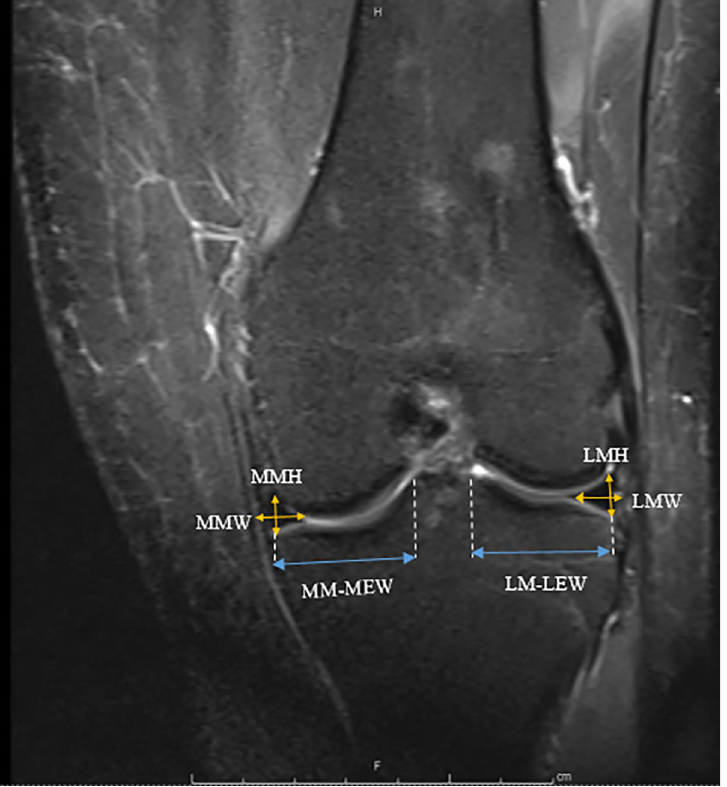
Fig 1. Mid-coronal section (MMH) Medial Meniscal Height, (MMW) Medial Meniscal Width (MM-MEW) MM-Medial Eminence Width (LMH) Lateral Meniscal Height (LMW) Lateral Meniscal Width (LM-LEW) LM Lateral Eminence